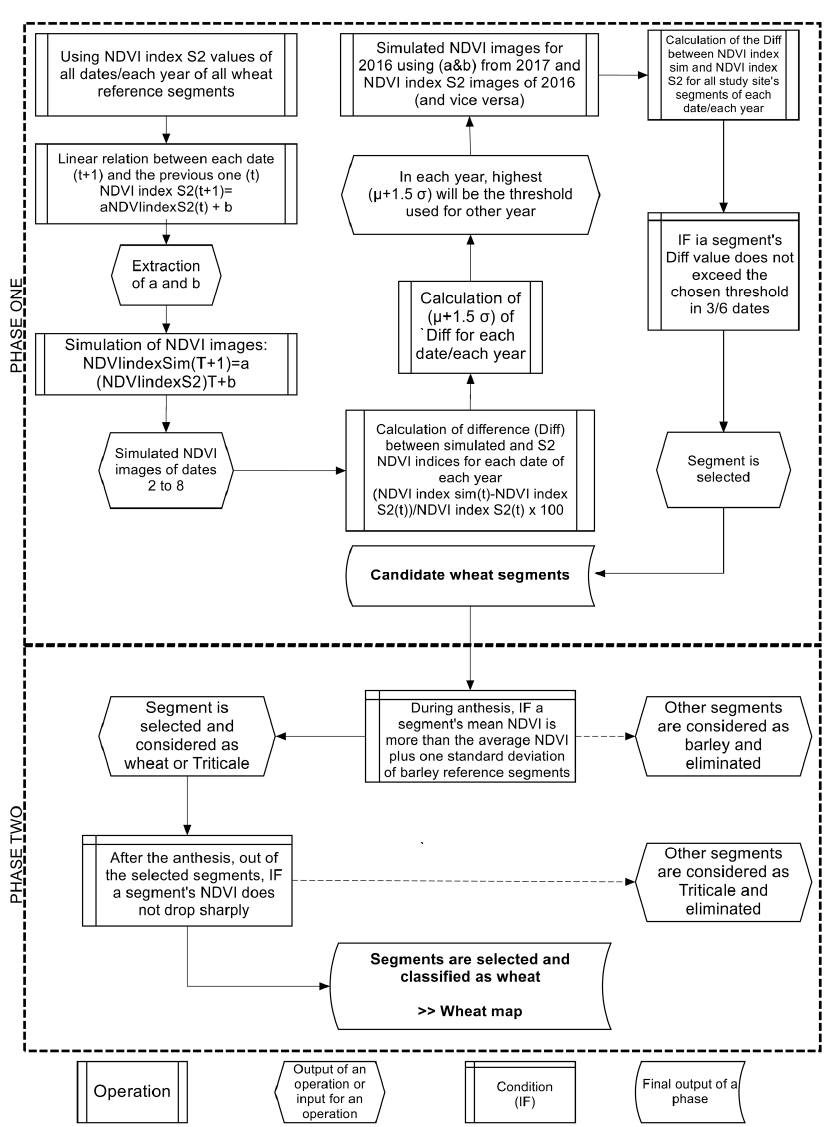
Figure 4. SEWMA (Simple and Effective Wheat Mapping Approach) simplified flowchart.